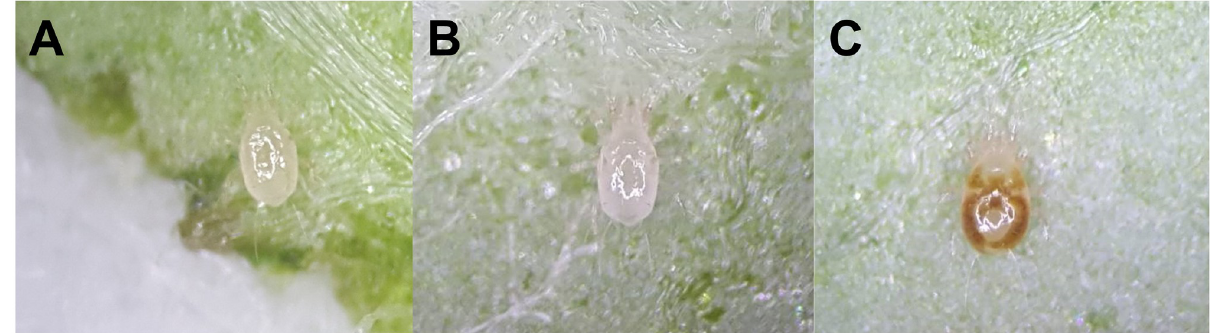
Fig 3. Comparison of pictures of female A . eharai according to prey consumed conditions. (A) Starved female for 24 hours. (B) Female that consumed T . urticae eggs for 24 hours. (C) Female that consumed T . urticae larvae for 24 hours.